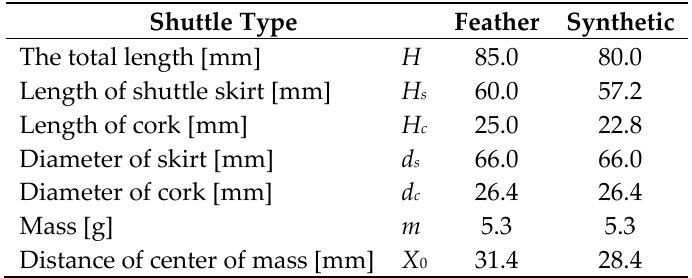
Table 1. The dimensions of two type shuttlecock.